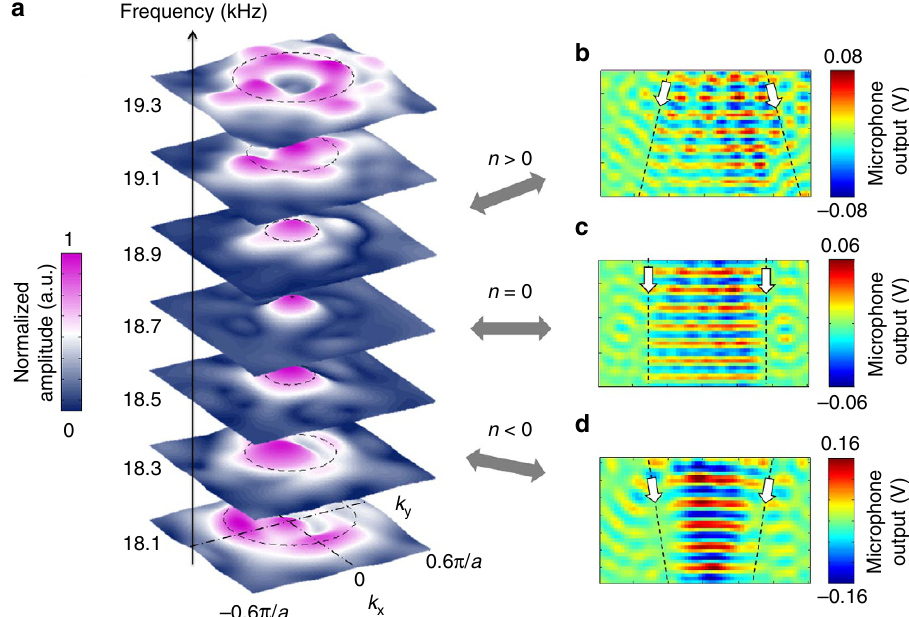
Figure 4 | Measurement of the Dirac-like cone and the associated interface acoustic refraction. ( a ) Experimentally resolved reciprocal space of the zero index metamaterial near the Brillouin zone centre at different frequencies. A ring is observed at low-frequencies and shrinks to a point at 18.7kHz. The ring opens again as the frequency increases. The black dashed circles represent the calculated equifrequency contours of the Dirac-like cone shown in Fig. 2b and agree well with the measurement. ( b – d ) Measured pressure fields outside the metamaterial at 19.1kHz, 18.7kHz and 17.9kHz, respectively. The black dashed lines and white arrows indicate the acoustic beam profiles and propagation directions. A focusing pattern is observed at 17.9kHz due to the double negative index property. An acoustic plane wave is obtained at 18.7kHz as a result of the double zero index metamaterial. The acoustic beam expands, when propagating at 19.1kHz because the material parameters are both